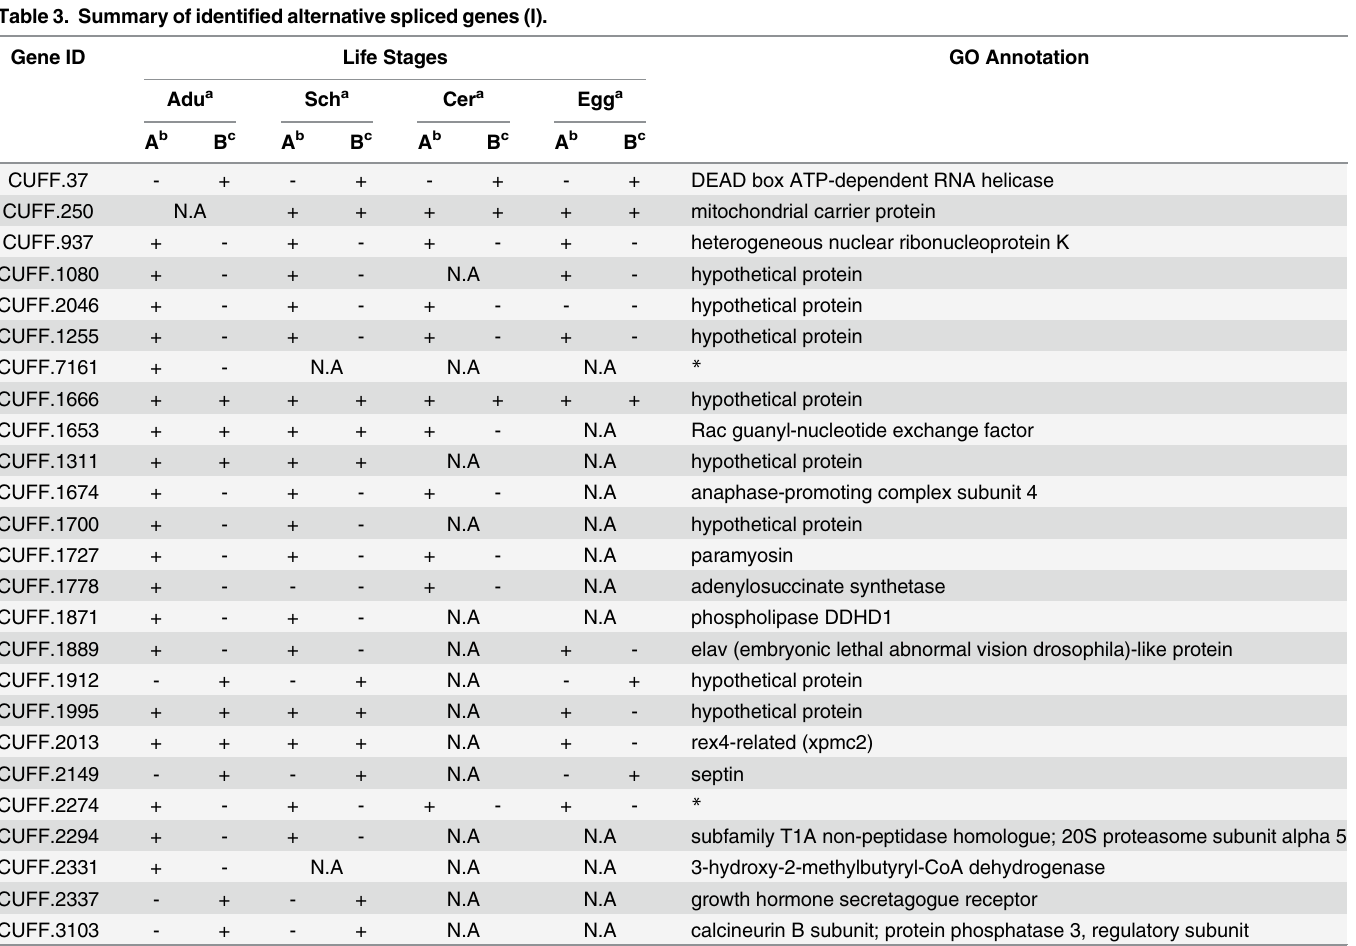
Table 3. Summary of identified alternative spliced genes (I). Gene